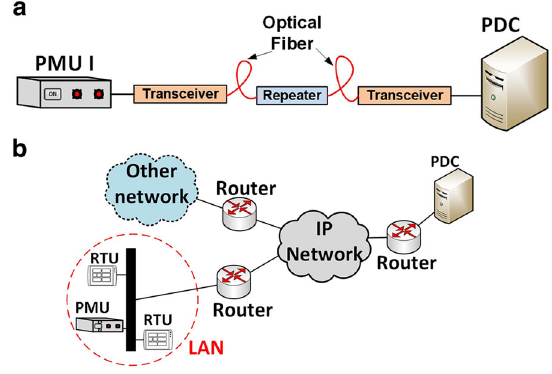
Fig. 13 a Dedicated Communication Network. b Shared Communication